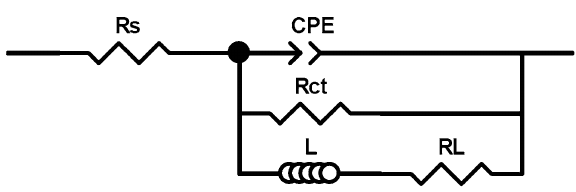
Figure 13. Equivalent electric circuit for quantitative estimation of EIS